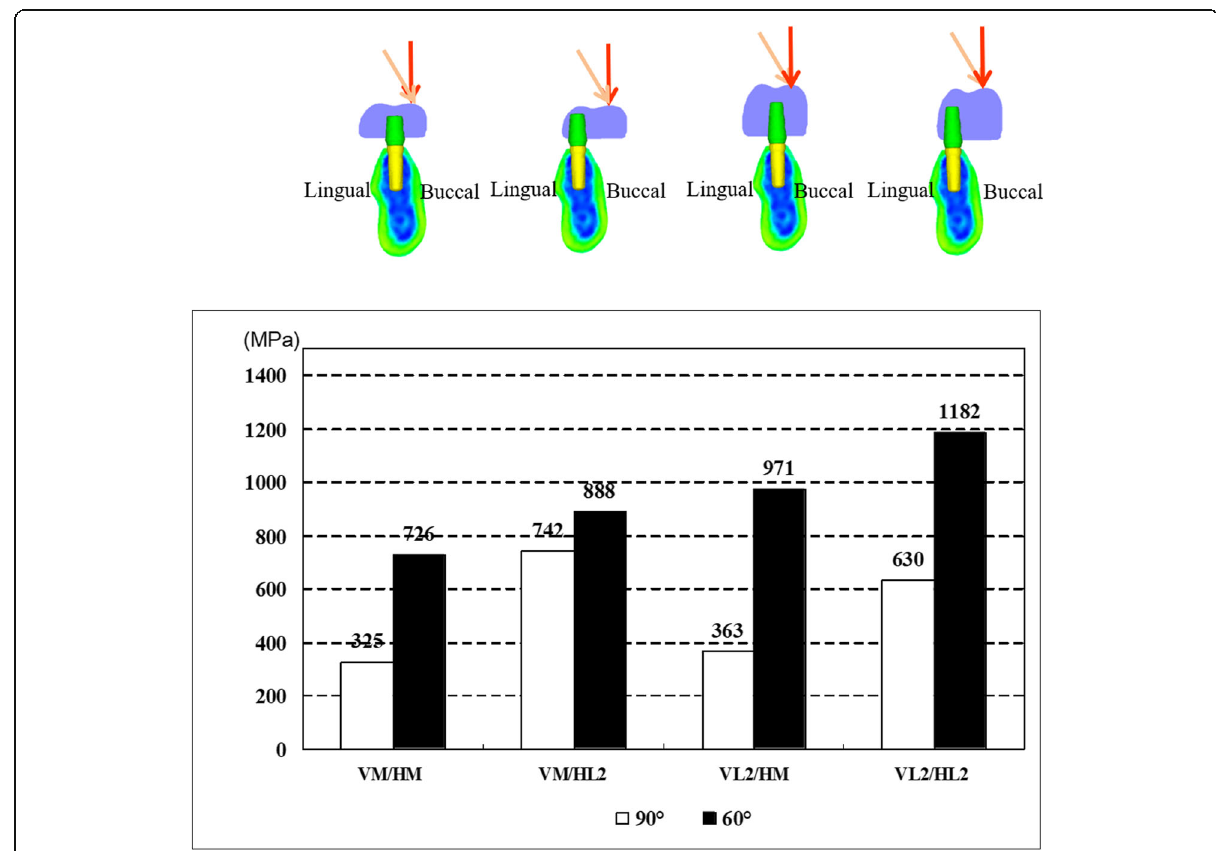
Fig. 15 Comparison of the maximum stress in abutments under 90°or